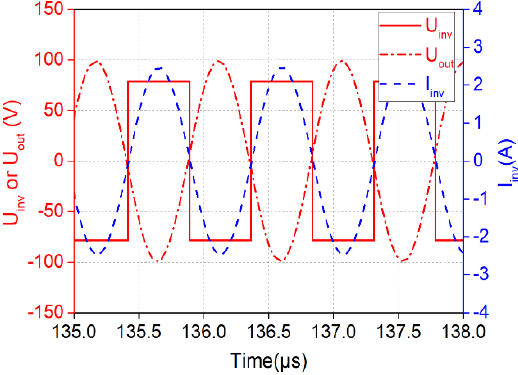
Figure 12. Waveform of inverter output voltage and current.